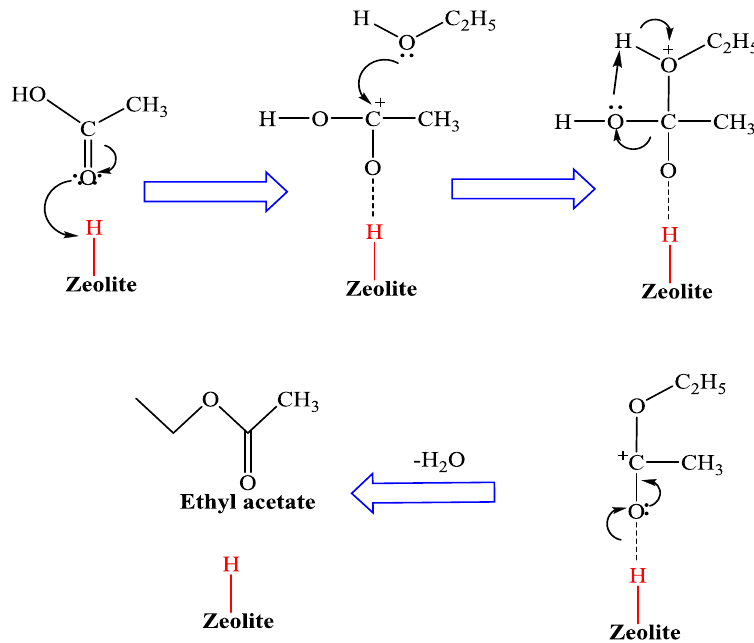
Figure 5. Vapor phase acetic acid esterification with ethanol. The adsorbed acetic acid on the zeolite catalyst forms a chemical linkage with the ethanol, followed by intramolecular dehydration to generate the water and ethylacetate [90] .